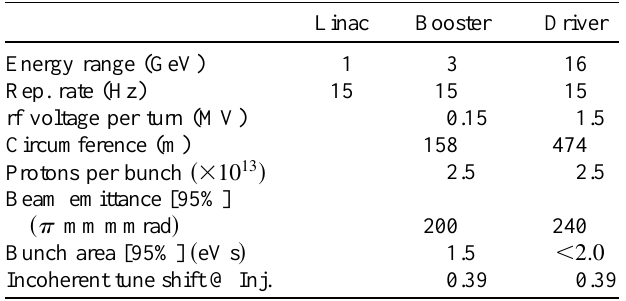
TABLE III. Baseline proton-driver parameters of the FNAL